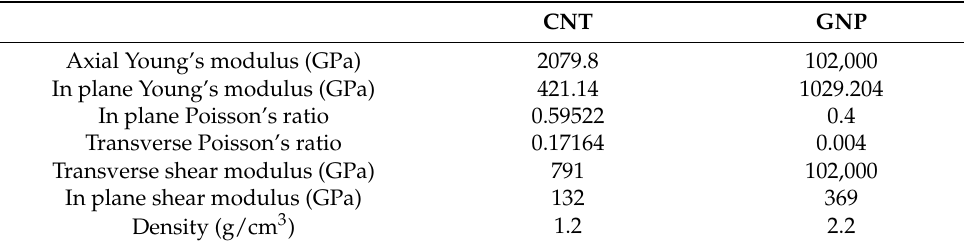
Table 6. Mechanical properties used in the Matlab code and Digimat MF for CNT and GNP.